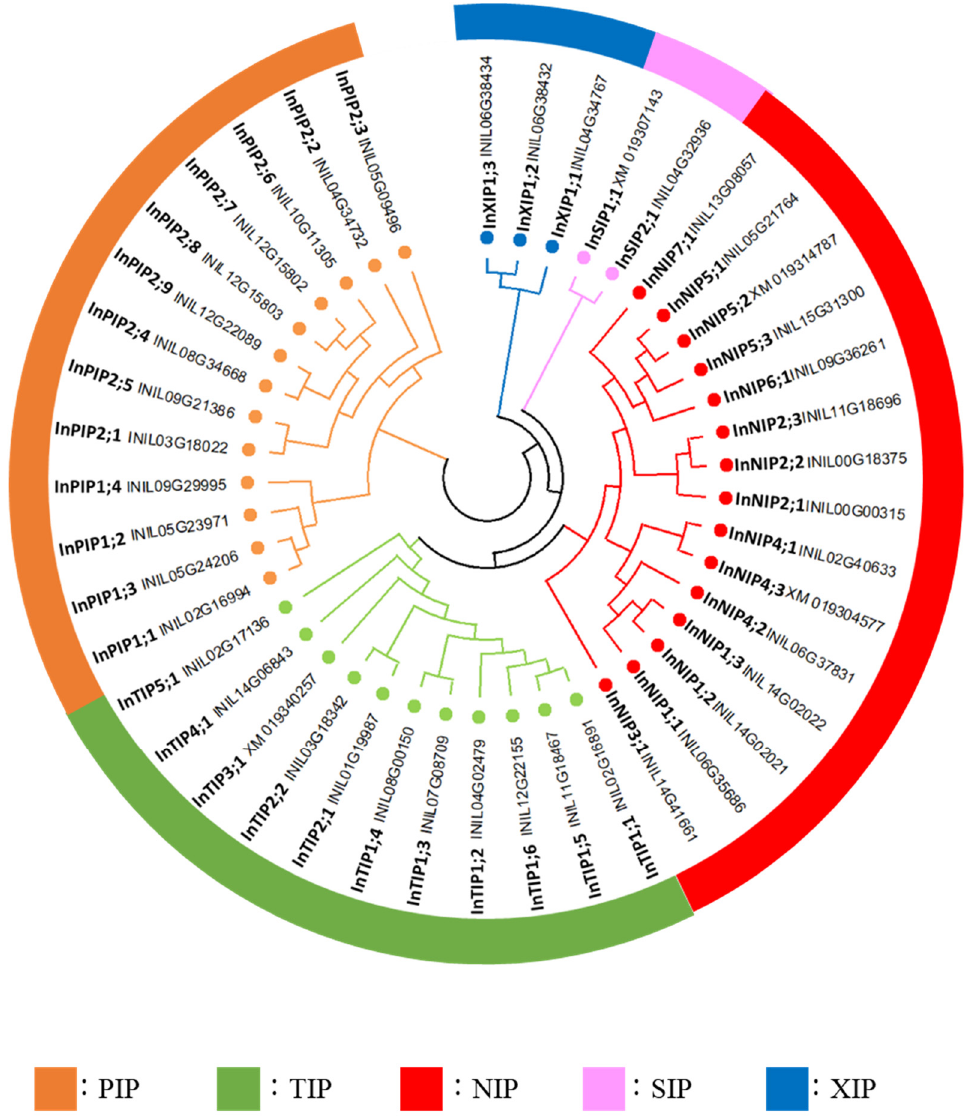
Figure 2. Phylogenetic tree of the AQPs of Japanese morning glory. Phylogenetic tree was gener- ated by the neighbor-joining method derived from a CLUSTAL alignment of the AQP amino acid sequences of Japanese morning glory.